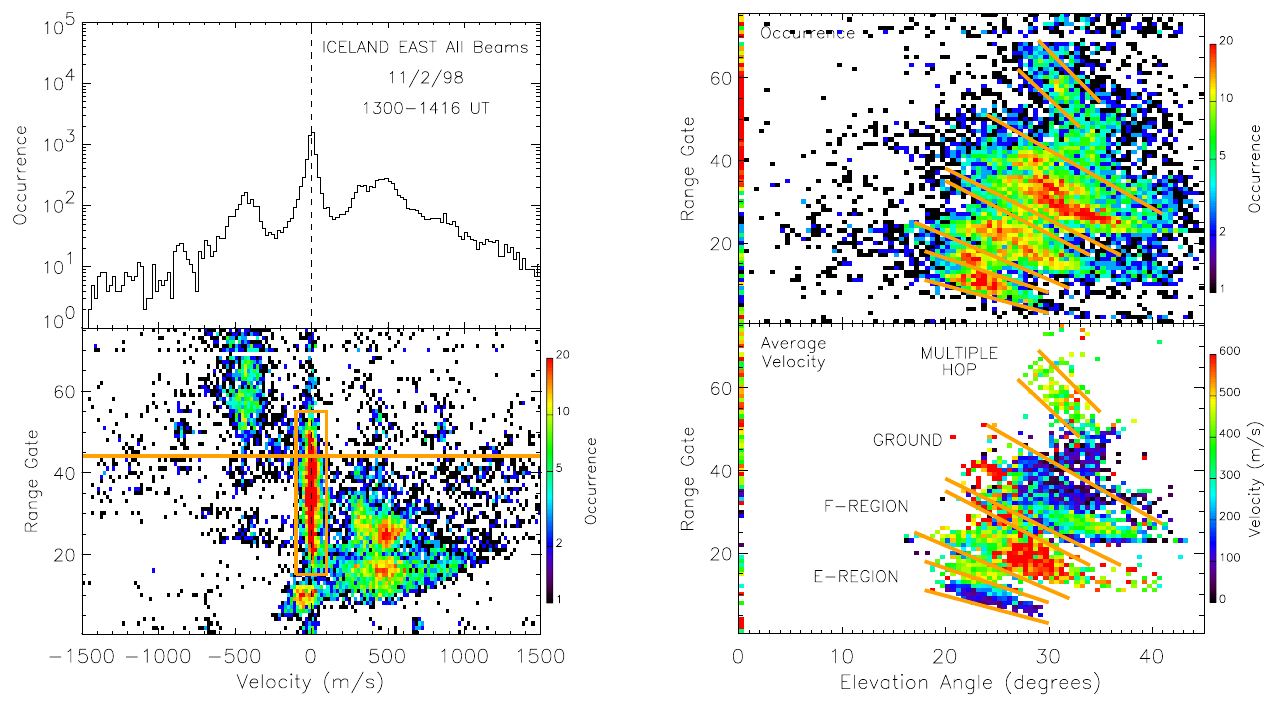
Fig. 11. (a) Line-of-sight velocity distribution from all beams of the Iceland East radar for the interval 13:00–14:16UT on 11 February 1998, as well as the distribution in range gate-velocity space. The orange rectangle represents the extent of the velocity-range gate filter applied to these data to remove contaminating ground backscatter. The horizontal orange line represents the range gate above which all data have been removed to eliminate possible contaminating E-region backscatter. (b) Occurrence distribution for the same interval in range gate elevation angle space, as well as the average velocity measured in each distribution cell.